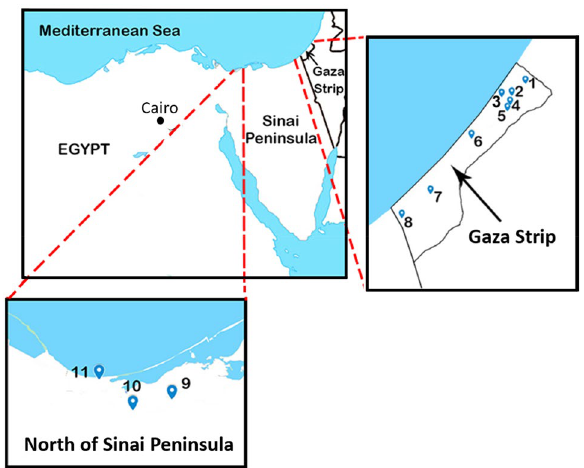
Figure 1. Sampling locations. Gaza Strip: (1) Beit Lahia, (2) Jabalia, (3) El Sheikh Radwan, (4) EL Tuffah, (5) Al Shejaiya, (6) Nuseirat (7) Khan Yunis and (8) Rafah. North of Sinai Peninsula: (9) Negela, (10) Qatia and (11) Rommana.